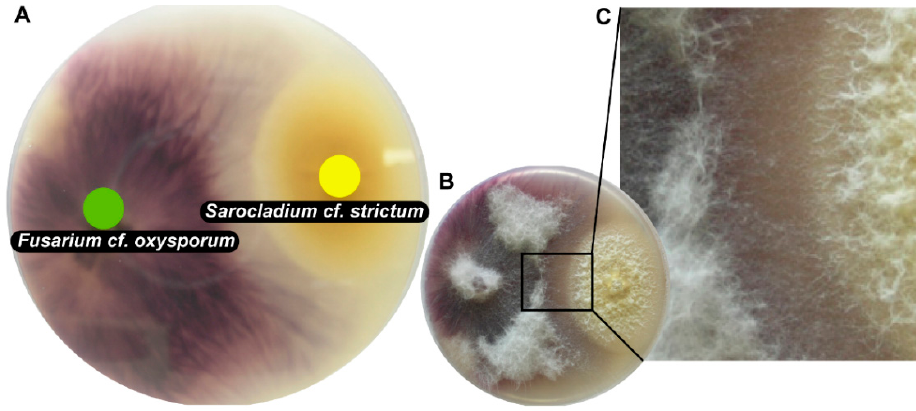
Figure 2. Picture of co-culture of Fusarium cf. oxysporum SIN17 and Sarocladium cf. strictum SIN29 grown on solid medium in 9-cm Petri dishes. ( A ) shows the bottom view of the co-culture with F. cf. oxysporum on the left (green dot) and S. cf. strictum to the right (yellow dot); ( B ) shows the top view of the co-culture; ( C ) shows a close-up view of the altered mycelial growth in the interaction zone between the two fungi.